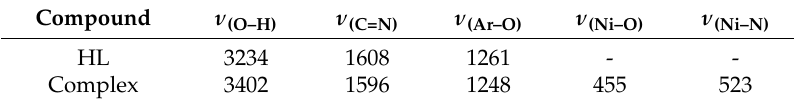
Table 2. The major IR spectra of HL and its Ni(II) complex (cm − 1